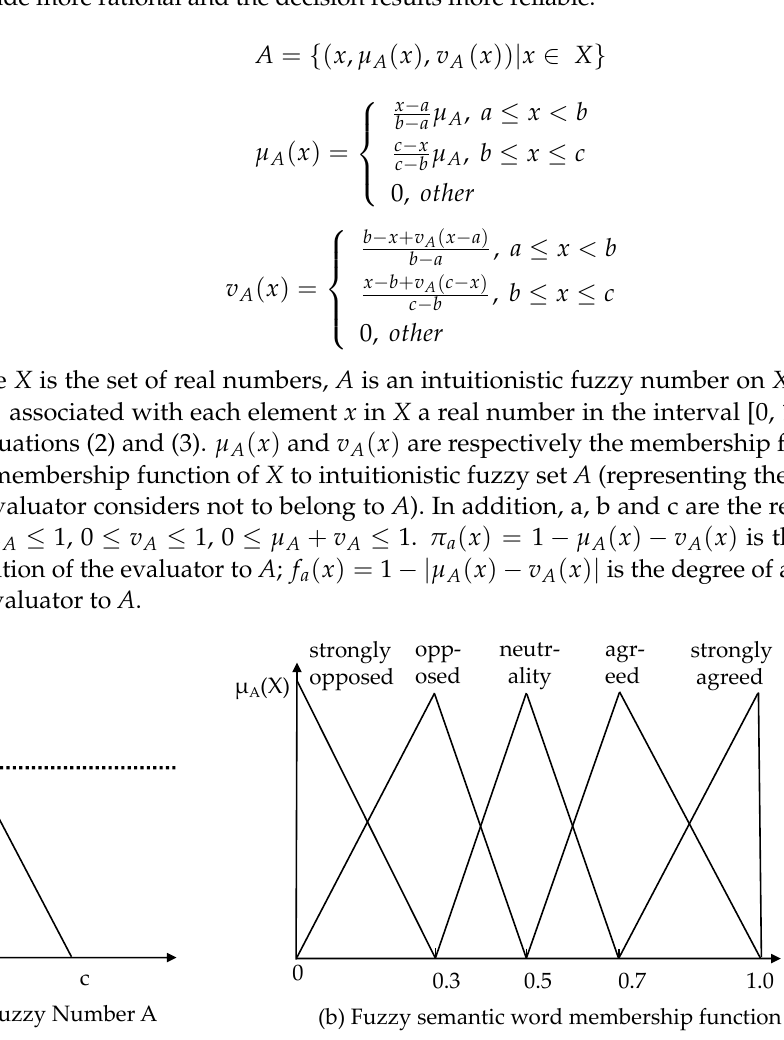
Figure 5. Triangular Fuzzy Number and its fuzzy semantic word membership function. The following Equations correspond to figure ( a ). Table 3 explains figure ( b ).